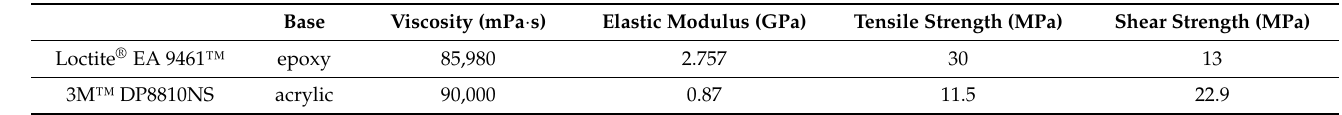
Table 2. Basic properties of the adhesives (technical data provided by the manufacturer for a substrate of CFRP).